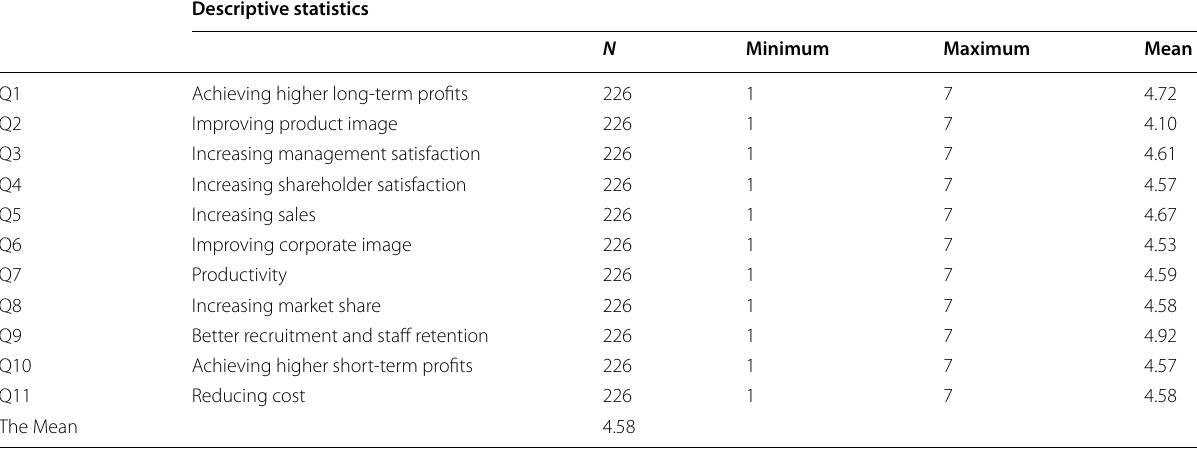
Table 3 Descriptive statistics of competitiveness Descriptive statistics